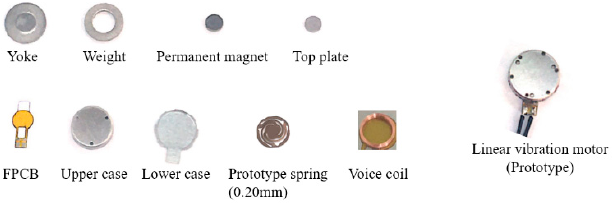
Figure 11. Each component of the linear vibration motor sample prototype.